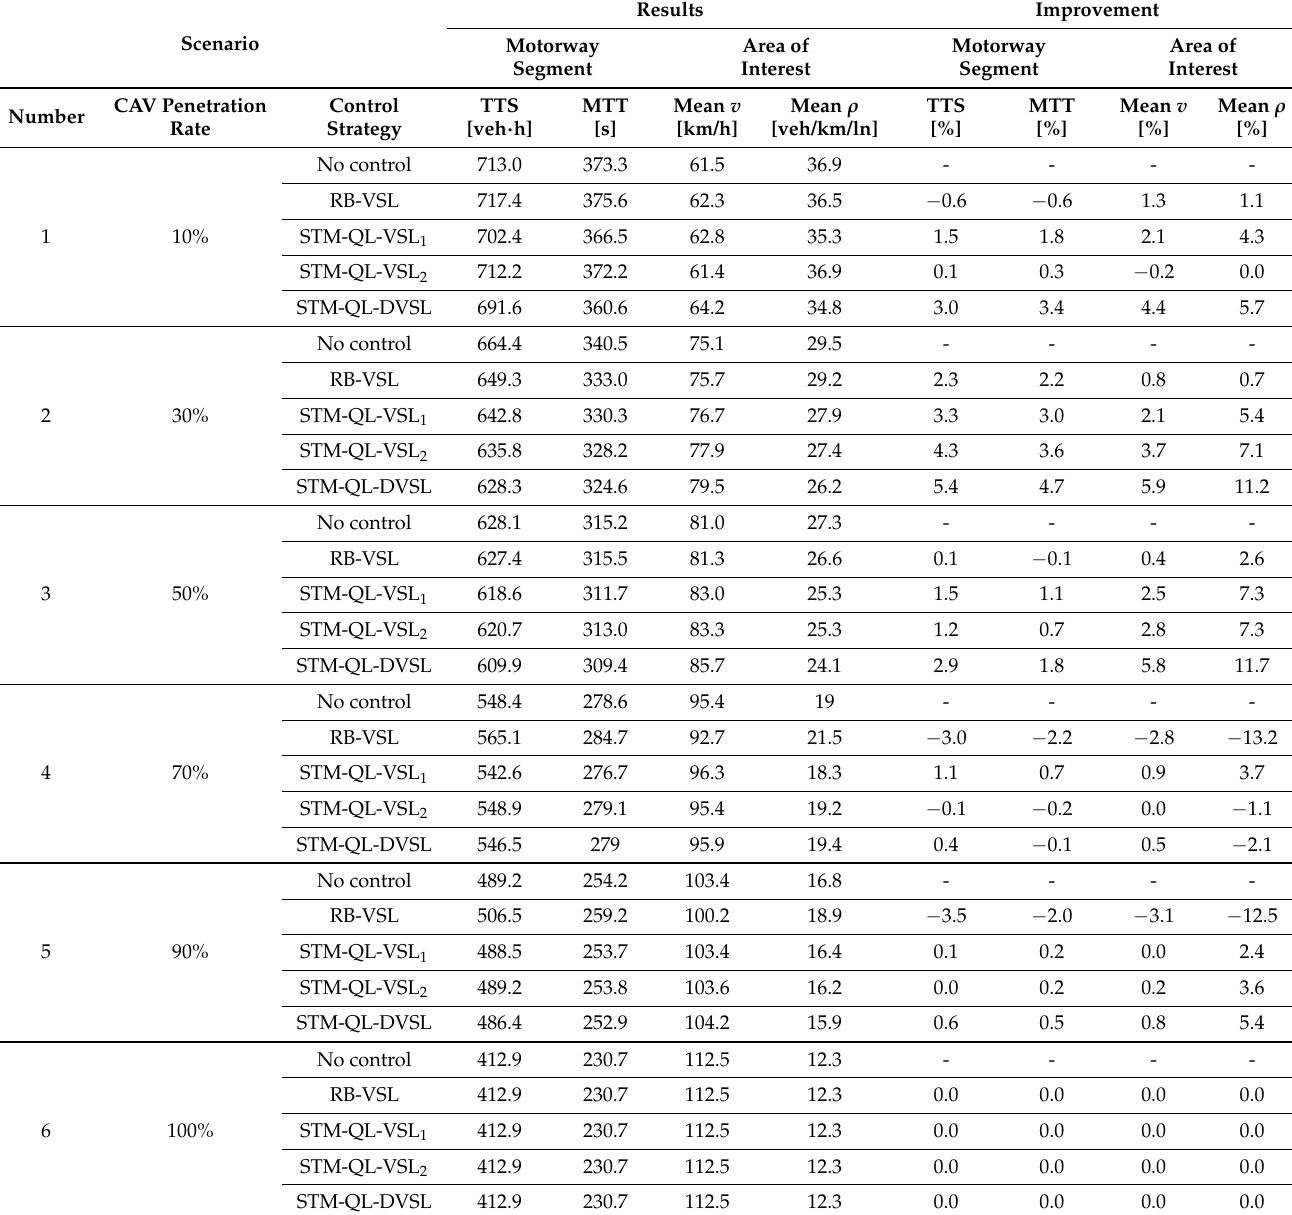
Table 1. Obtained performance for defined scenarios with different CAV penetration